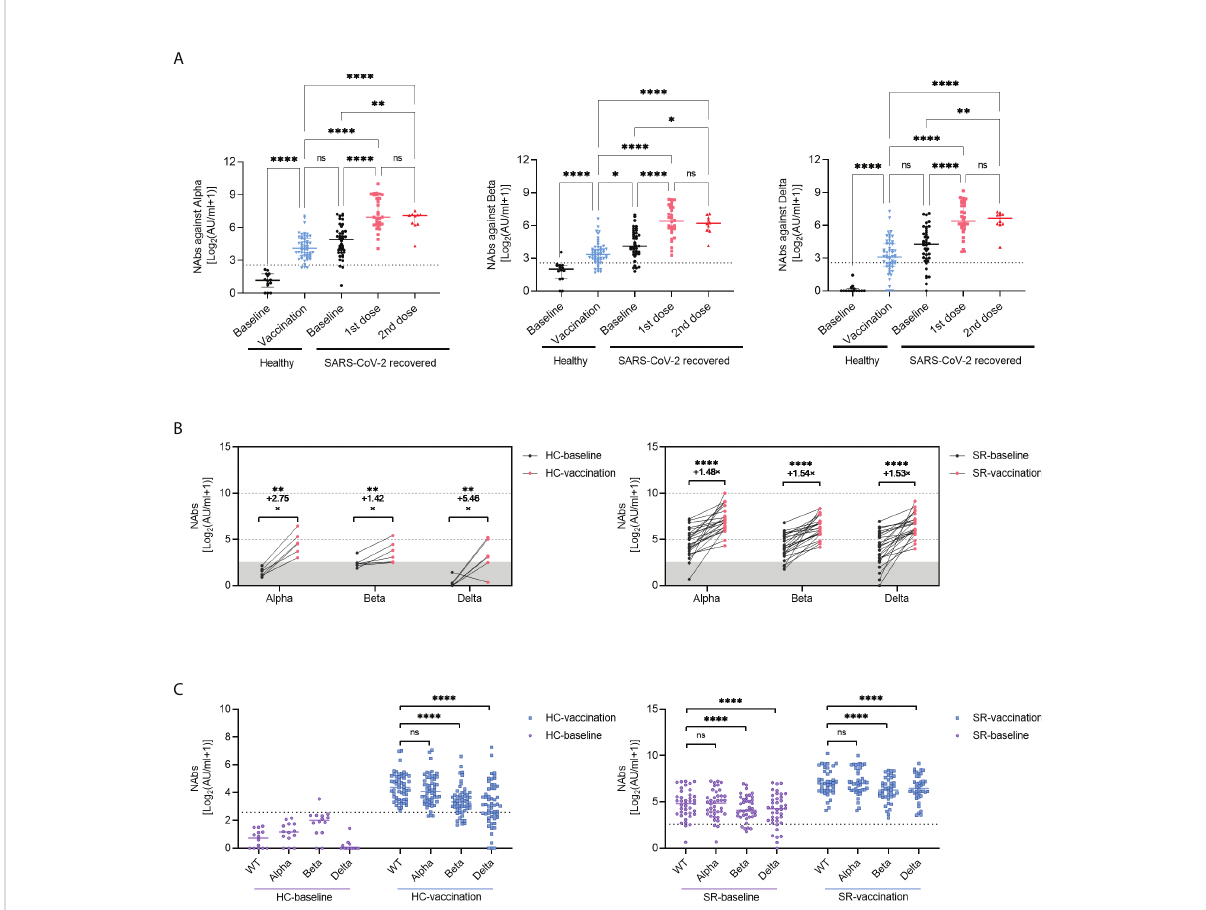
FIGURE 2 Neutralizing Antibody against variant of concerns (VOCs) following inactivated vaccination. (A) The titers of NAbs (VOCs) before or after vaccination in SR (baseline, N=40; vaccination, N=40 with 1st dose, N=30; 2nd dose, N=10) and HC (Baseline, N=14; vaccination, N=55) group. Data are shown with median and IQR. (B) he changes of NAbs against VOCs increased pre- (black) and post- (red) vaccination in paired HC (N=6, paired data) and SR (N=24, paired data) individuals. (C) he comparison of NAbs titers between SARS-CoV-2 wild type(WT)and VOCs in HC (left) and SR (right) group. The horizontal dotted line or shadow represented the cut-off value. Kruskal-Wallis test followed by Dunn ’ s multiple comparisons test (A, C) and paired t-test (B) were used for statistical analysis. ns: no signi fi cance, * P < 0.05, ** P <0.01, **** P < 0.0001. HC, healthy control; SR, SARS-CoV-2 recovered